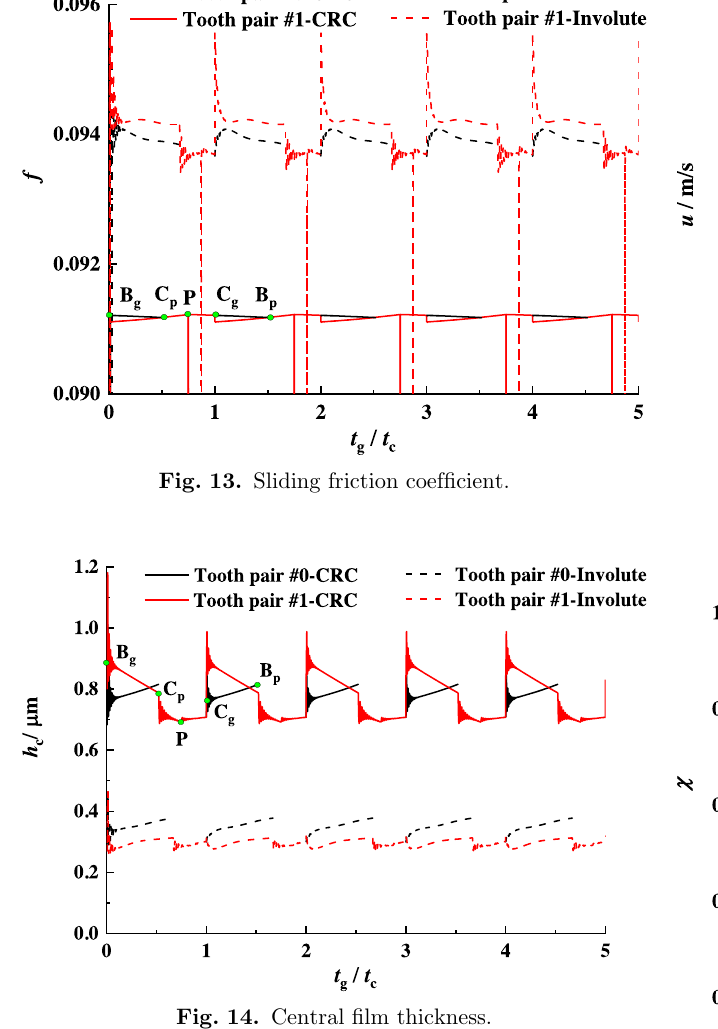
Fig. 14. Central fi lm thickness.